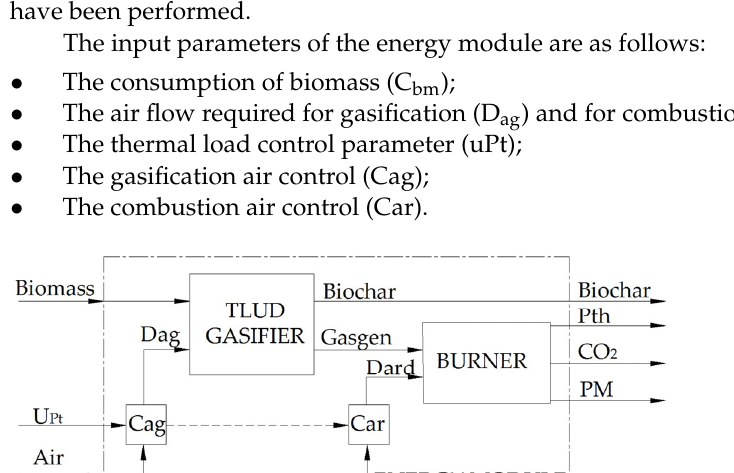
Figure 2. Comparison of CO and PM emissions from various combustion technologies and systems [16].